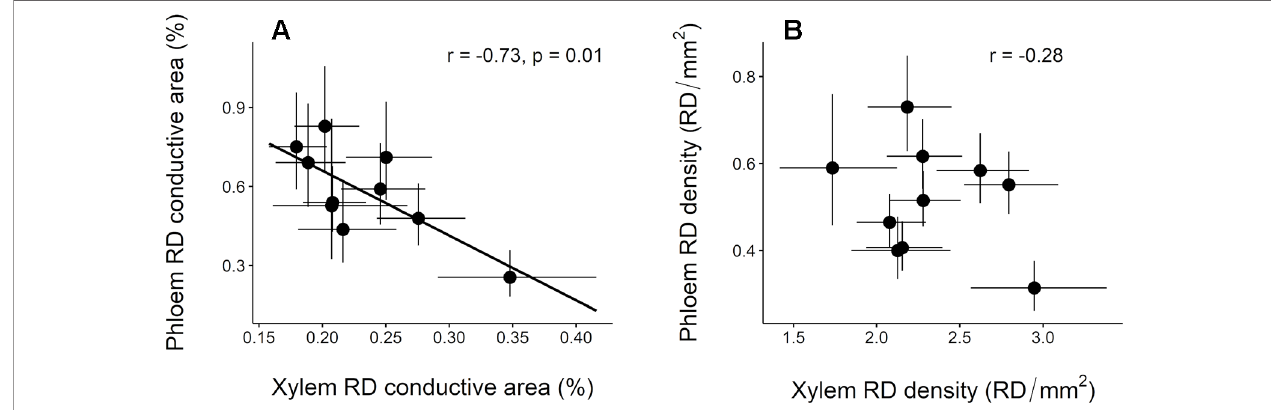
FIGURE 5 | Relationship between constitutive resin duct features in the xylem and phloem across 10 Pinus pinaster populations. (A) Resin duct conductive area (RD conductive area, %) and (B) resin duct density (RD density, RD/mm2). Each point represents the population least square means ± SE extracted from the mixed model. Pearson correlation coef fi cient (r) and associated p-values (p) are